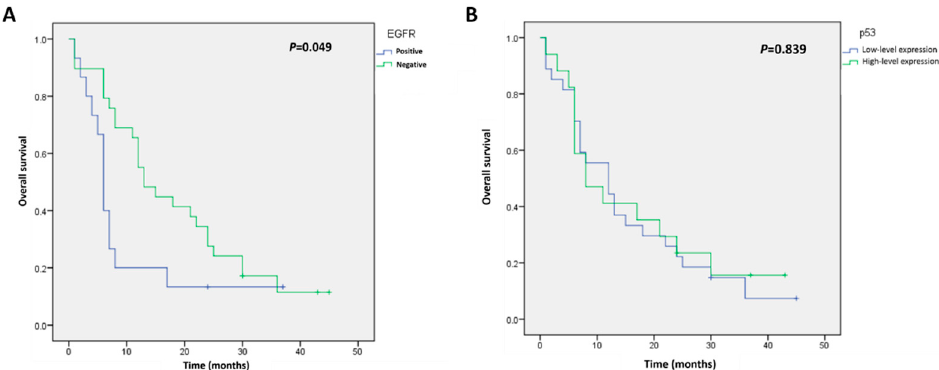
Figure 3. Kaplan–Meier analysis of overall survival in patients with astrocytomas according to ( A ) EGFR expression or ( B ) p53 expression.